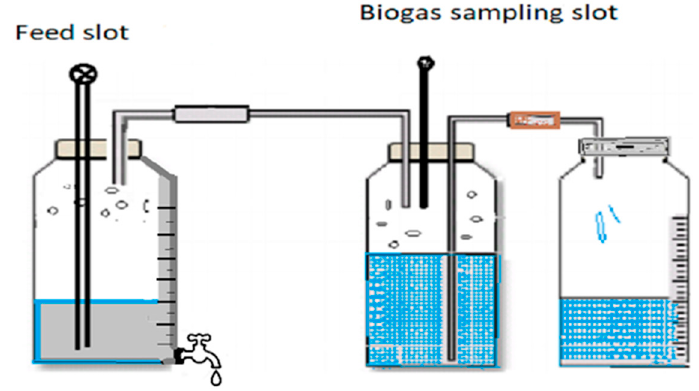
Figure 1. Anaerobic digestion reactor configuration.